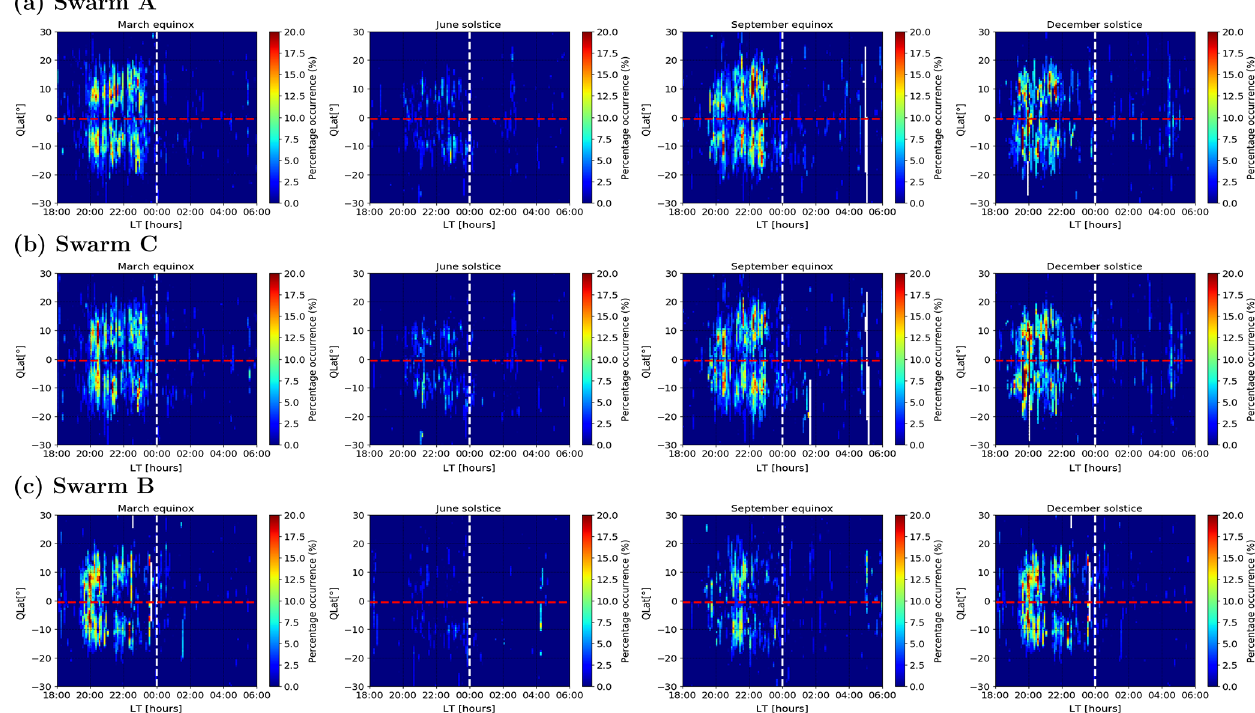
Figure 12. Quasi-dipole latitude and local time distributions of the IBI for Swarm A, C, and B for the years from 2014 to 2018. The dotted white vertical line represents midnight, and the dotted red horizontal line represents the quasi-dipole latitude of Jicamarca ( ≈ − 0 . 6 ◦ ). The white spaces represent data